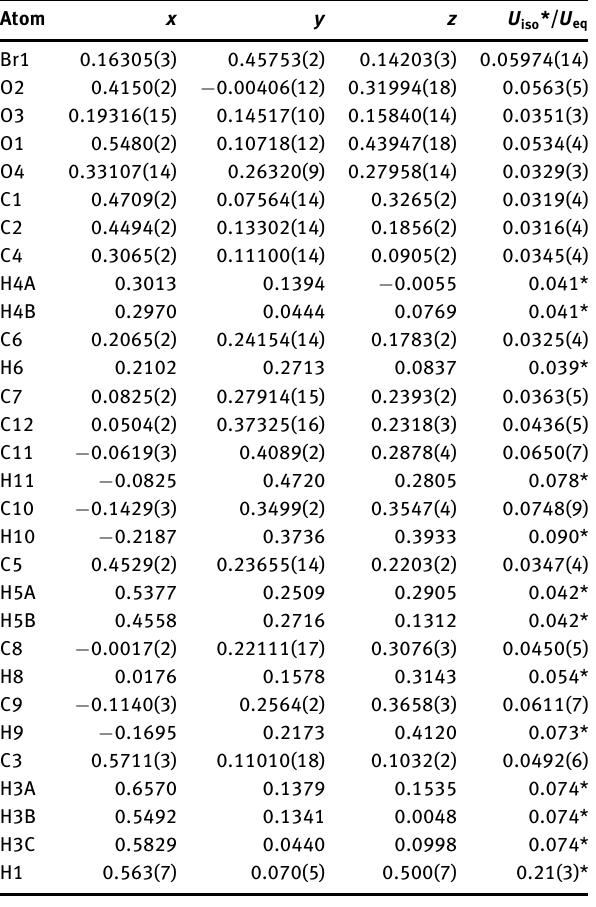
Table 2: Fractional atomic coordinates and isotropic or equivalent isotropic displacement parameters (Å 2